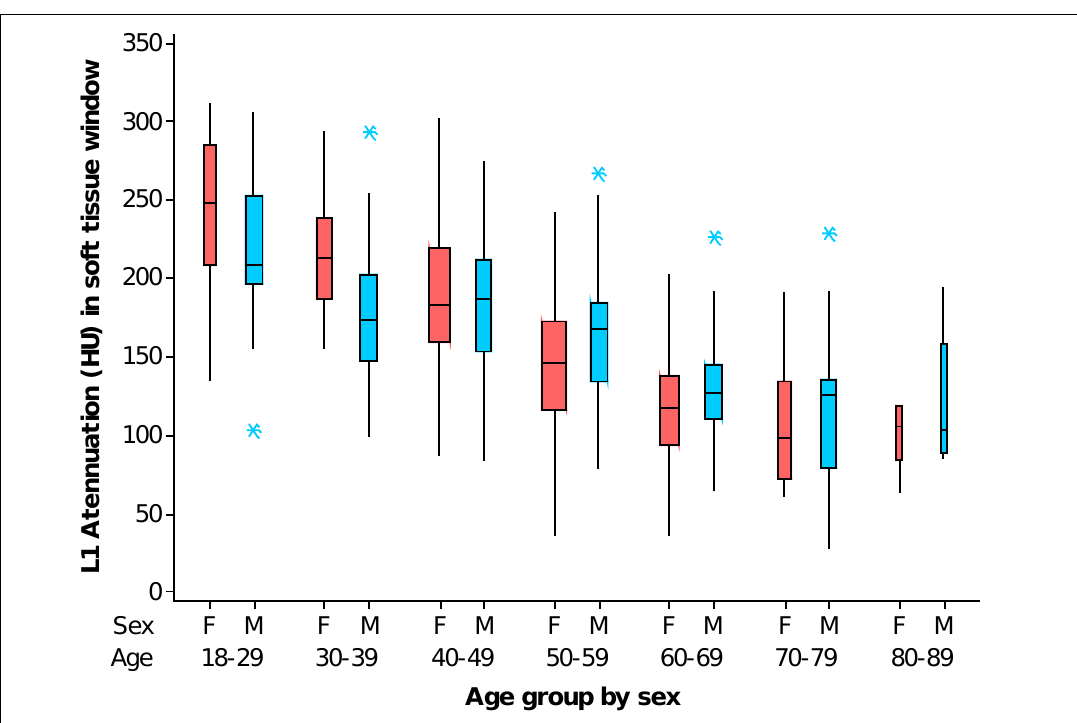
8 HU: Hounsfield units ; SD: Standard deviation; Q1: First quartile; Q3: Third quartile.